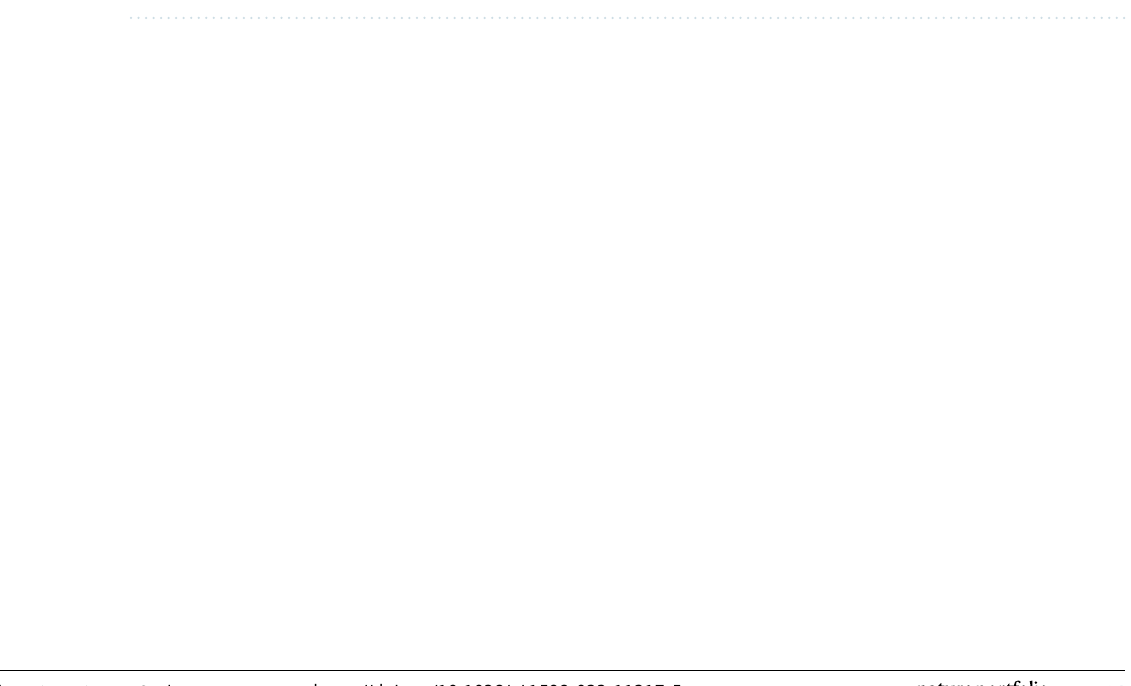
Figure 12. ( a–d ) Represent the P@N curves on CIFAR-10 of all methods with different bit. (Created by “matlab R2019a” url: https:// ww2. mathw orks. cn/ produ cts/ matlab.